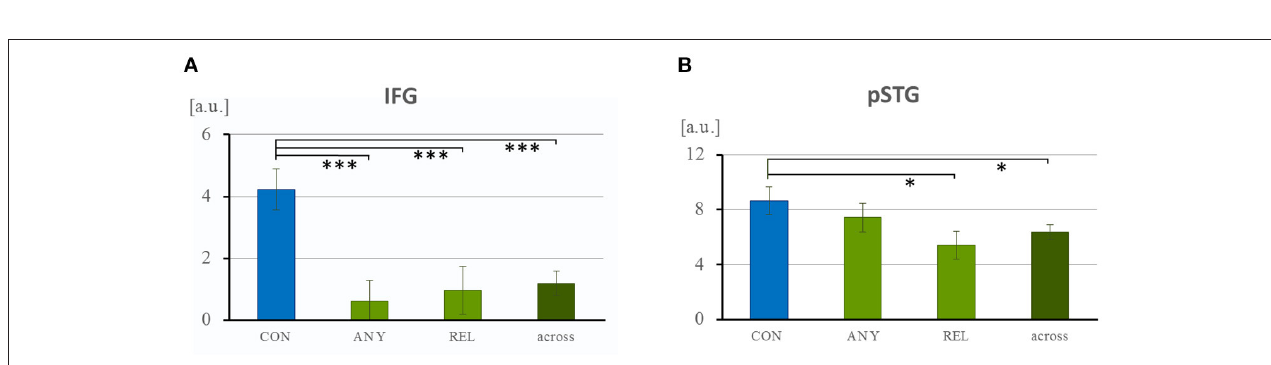
FIGURE 7 | Region-of-interest analysis of the left IFG and pSTG. (A) Task-specific recruitment of the language networks left IFG and pSTG were examined with anatomically-defined ROIs. Across each ROI, averaged covariance values were extracted. (A) In the left IFG, neural synchrony was specifically higher during the CON task and close to zero for the other tasks and across tasks. (B) In the pSTG, the task effect was much weaker but ISC in general much higher. [a.u.], arbitrary unit; CON, task to attend to conventionality in co-speech gesture; ANY, task to attend to any hand movement; REL, task to attend to the gesture-speech relation. * p < 0.05; *** p <